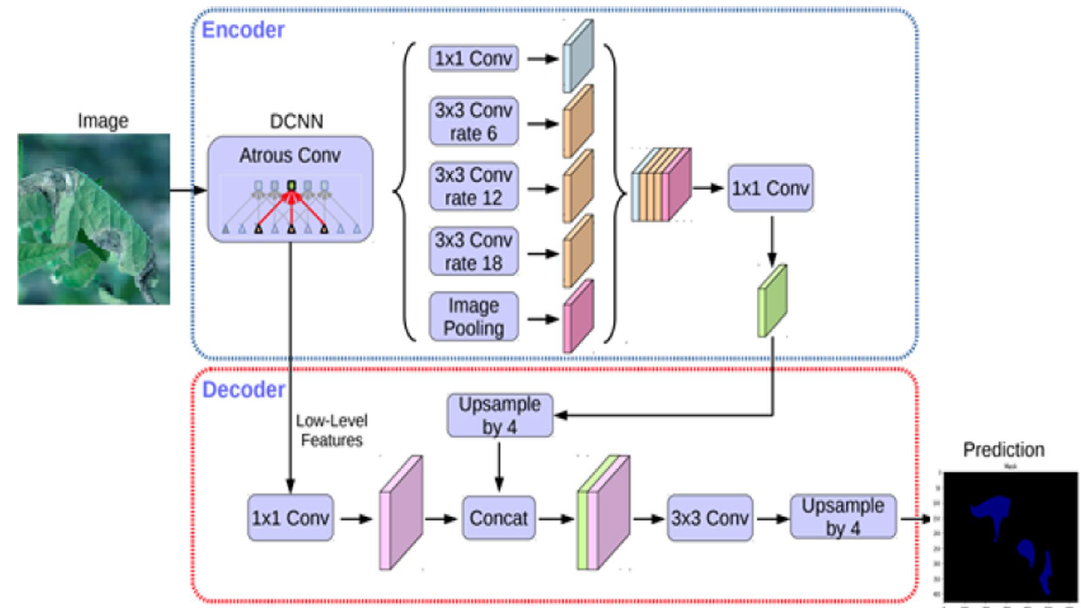
Fig. 7 The architecture of the Deep Lav3 +